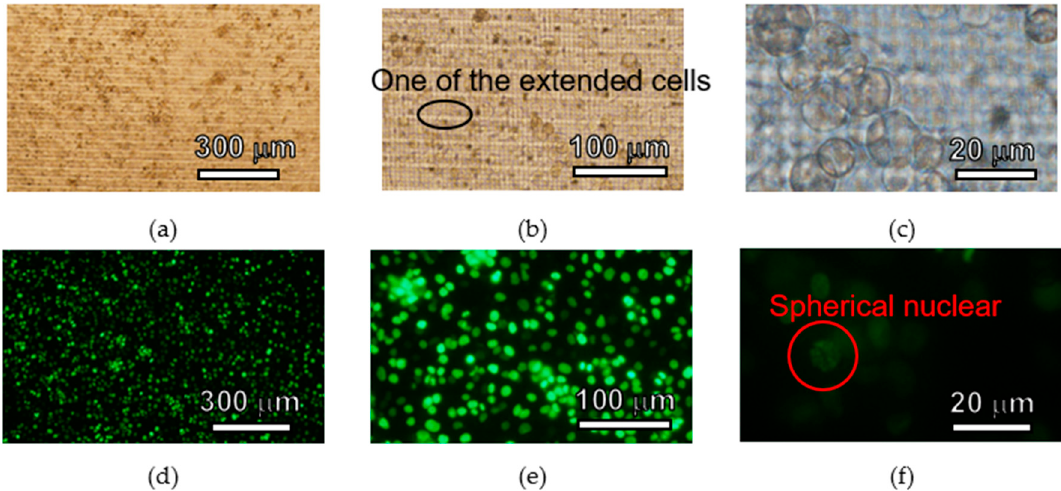
Figure 9. Images of HeLa cells cultured 5 days on the cell culture plate. ( a ) Bright field (×40). ( b ) Bright field (×100). ( c ) Bright field (×400). ( d ) Fluorescent (×40). ( e ) Fluorescent (×100). ( f ) Fluorescent (×400).